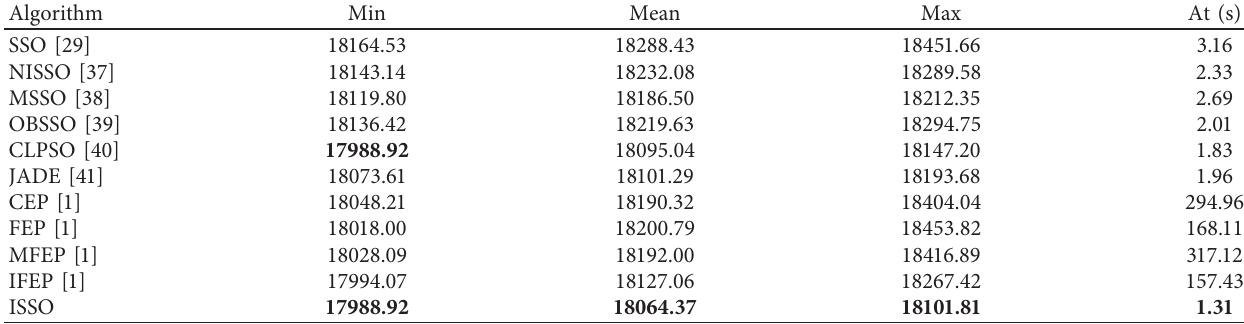
Table 5: Comparisons of the results of 13-unit system with P